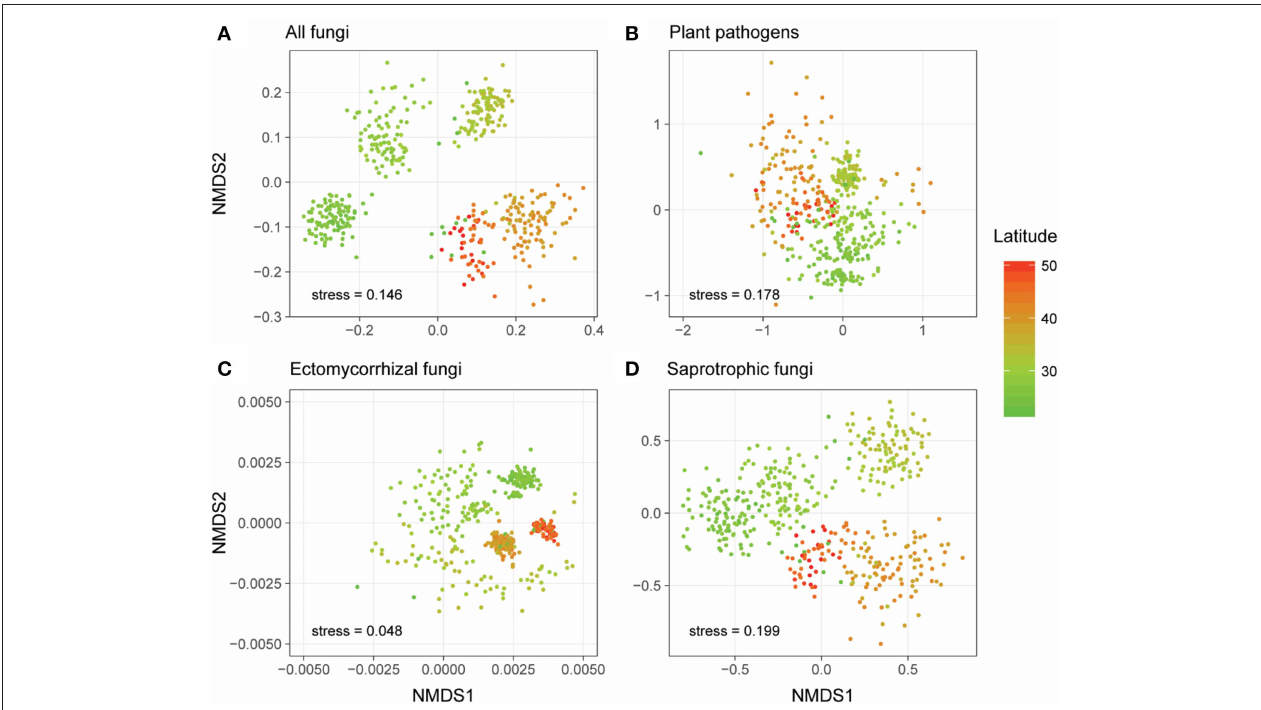
FIGURE 2 | Non-metric multidimensional scaling (NMDS) ordinations of the community compositions (OTU level) of all fungi (A) , plant pathogens (B) , ectomycorrhizal fungi (EMF) (C) , and saprotrophic fungi (D) based on Jaccard distance. Sample points were colored based on their latitude